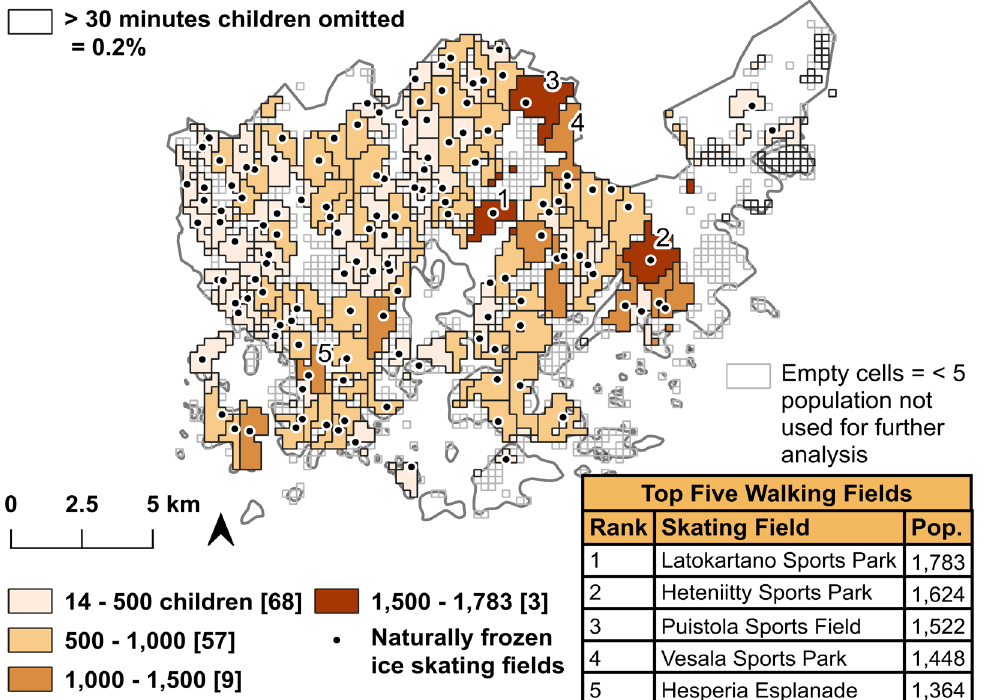
Fig. 4. Population catchment areas for children and adolescents of naturally frozen ice skating fields based on travel time by foot.